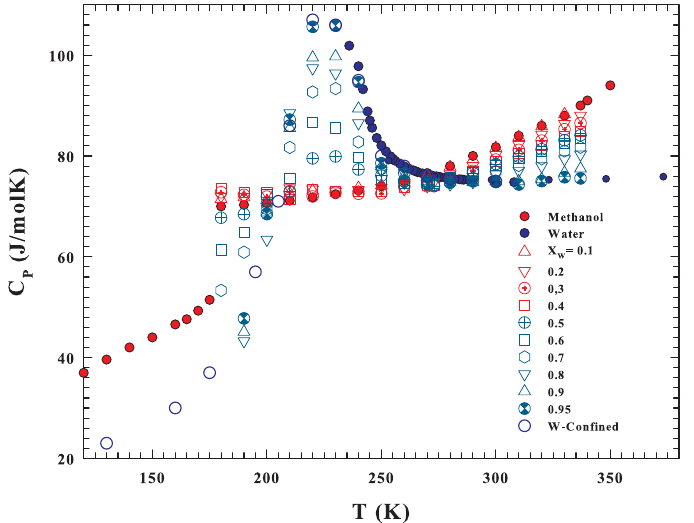
Figure 9. The figure show the total specific heat of the water–methanol system including their solution